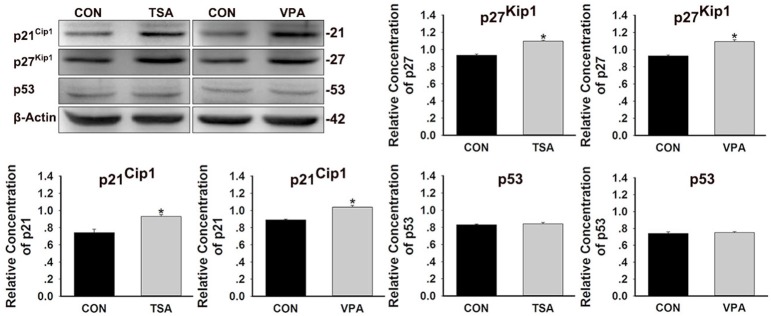
Effects of HDAC inhibitors on the expression of p21Cip1, p27Kip1, and p53 protein. After treatment of larvae with 0.1 μM TSA or 100 μM VPA for 48 h, protein extracts were prepared and subjected to western blot assay using antibodies against p21Cip1, p27Kip1, and p53. β-Actin was included as the control. Mean ± s.e.m. for three experimental replicates. *p < 0.05.